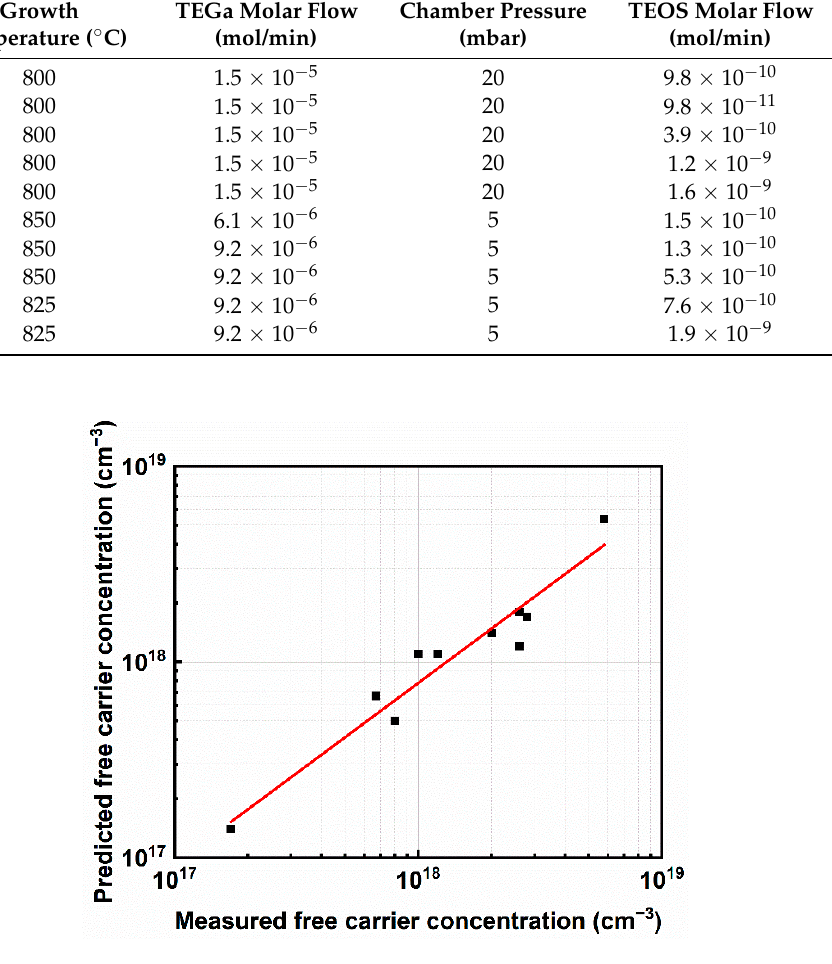
Figure 4. Measured values and predicted values of free-carrier concentration from (010) β -Ga 2 O 3 thin films with the process parameters listed in Table 2 .